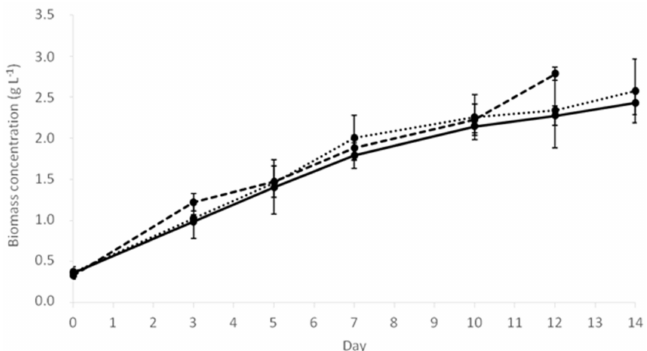
Figure 1. Growth curves of A. platensis F&M-C256 grown at three different iron concentrations: 1 mg L − 1 (continuous line), 5 mg L − 1 (line with dots), and 10 mg L − 1 (line with dashes). Values are expressed in g L − 1 and are reported as means ± SD ( n =